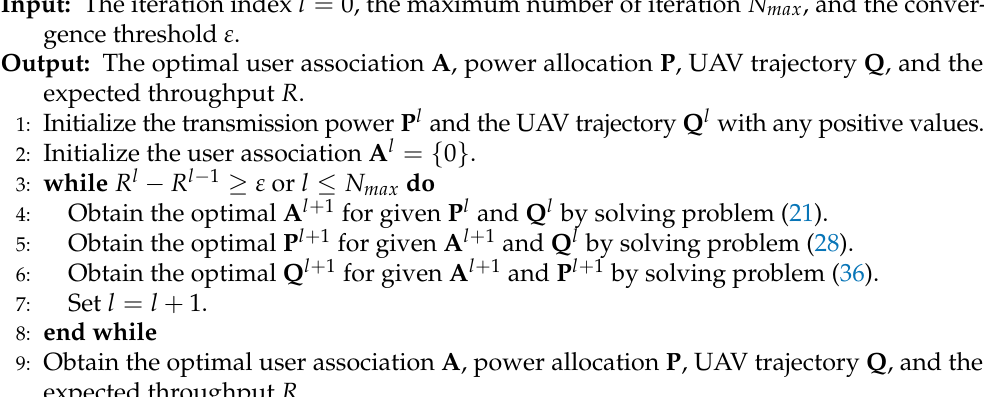
Algorithm 1 Joint user association, power allocation, and UAV trajectory optimization